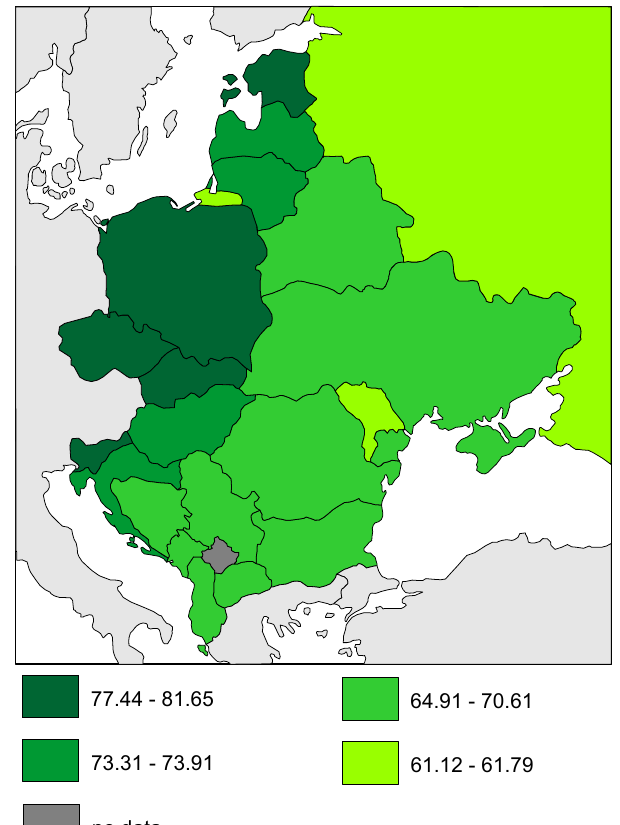
Fig. 2. The values of the Social Progress Index in European post-Communist countries in 2014 (source: http://www.socialprogressimperative.org/)